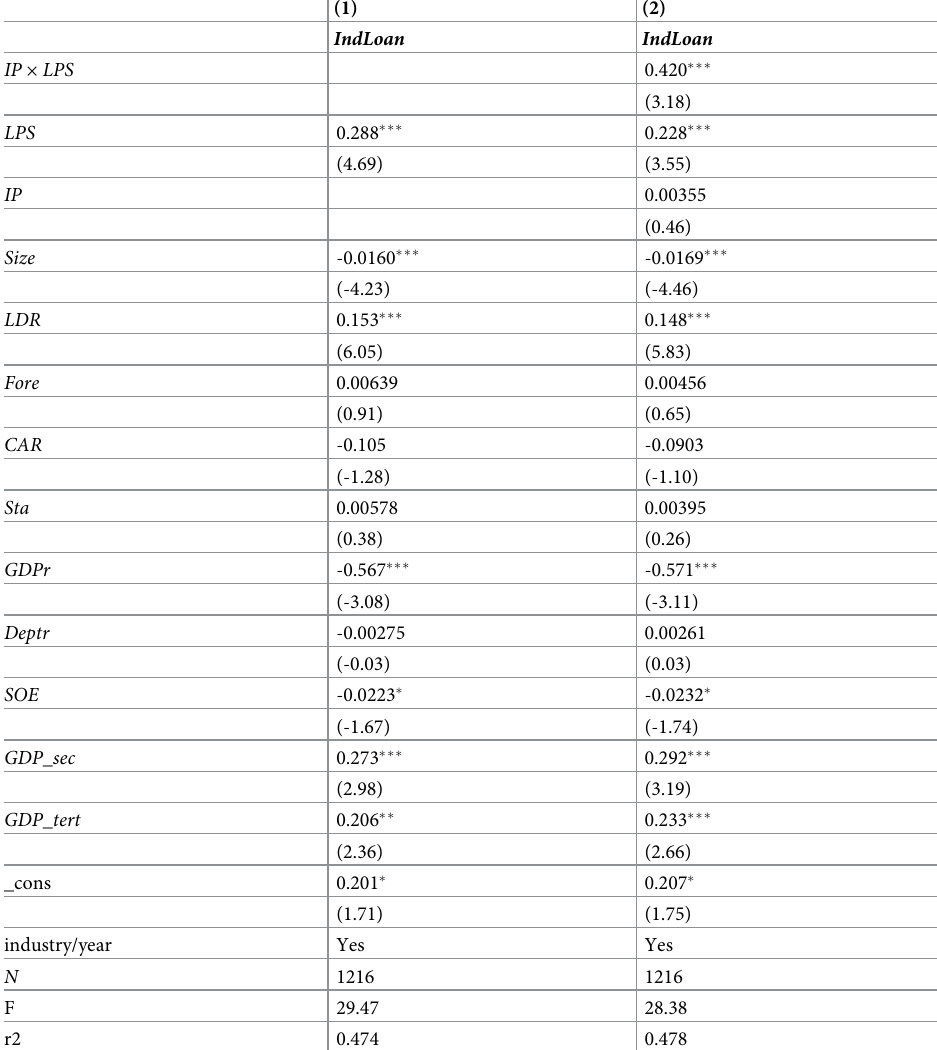
Table 4. Large private shareholders, industrial policies and industrial loans of city commercial